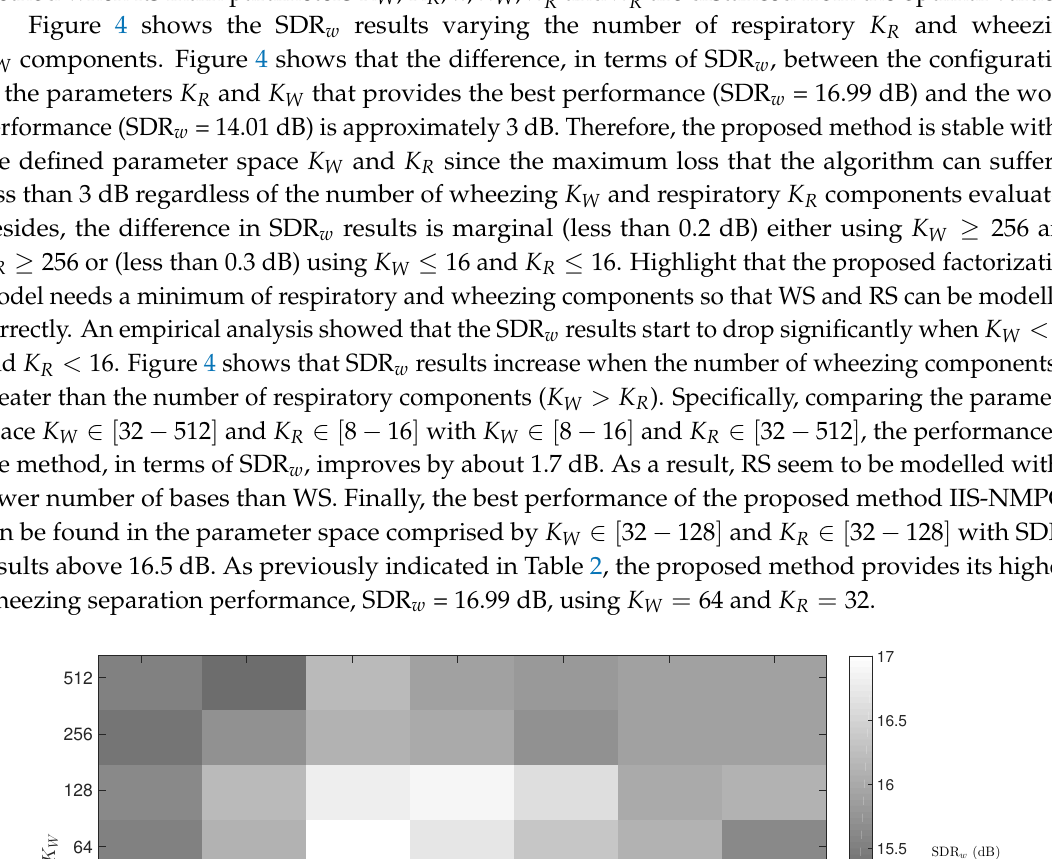
= 10, α = 1, λ 1 = 0.1 R R